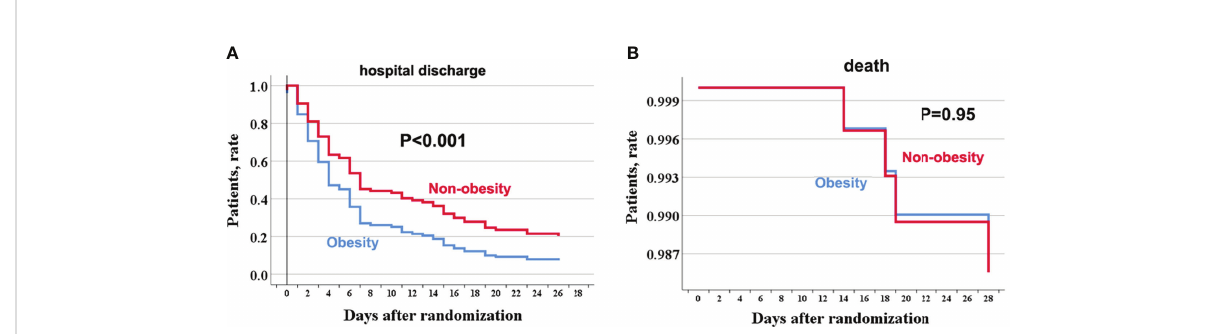
FIGURE 1 The age-adjusted incidence rate of hospital discharge and death through 28 days among obese and no-obese hospitalized patients with COVID-19 without comorbidities. hospitalization (A) ; death (B) . For hospital discharge, all patients were followed up to discharge or 28 days after randomization in ORCHID. A patient was considered discharged from the hospital once discharged from the index hospitalization; rehospitalizations were not considered in this analysis. COVID-19, Corona Virus Disease 2019; ORCHID, Outcomes Related to COVID-19 Treated With Hydroxychloroquine Among Inpatients With Symptomatic